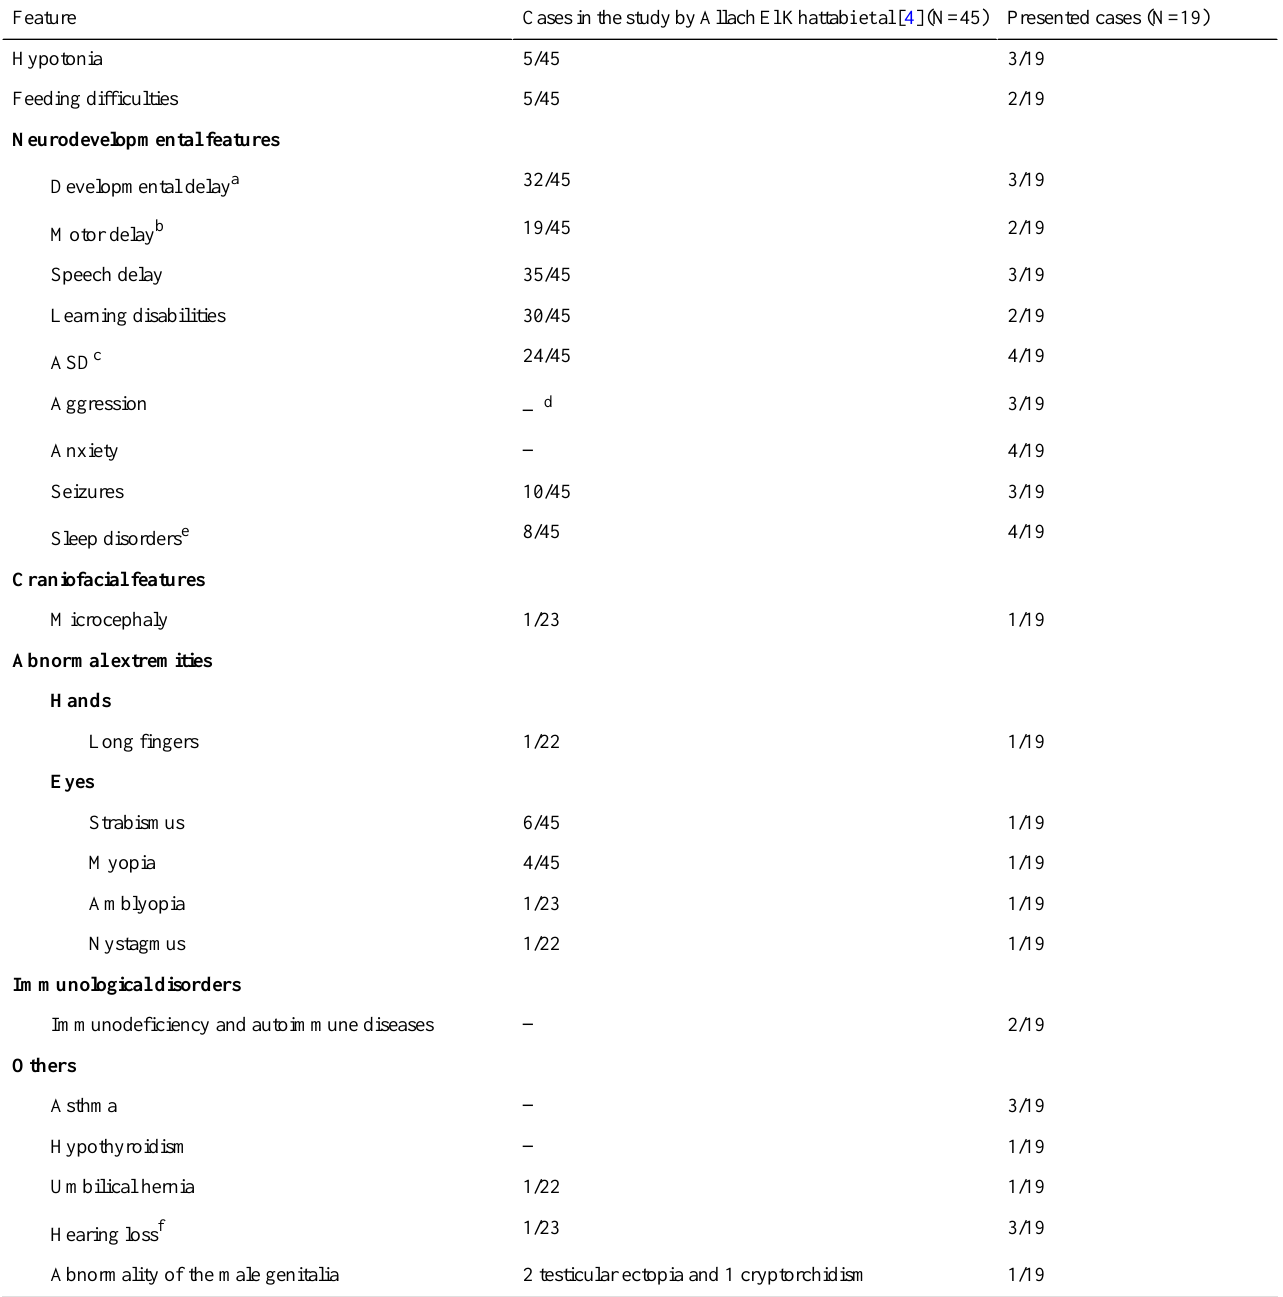
Table 2. Comparison of the self-phenotyping cohort with the published cohort in the study by Allach El Khattabi et al